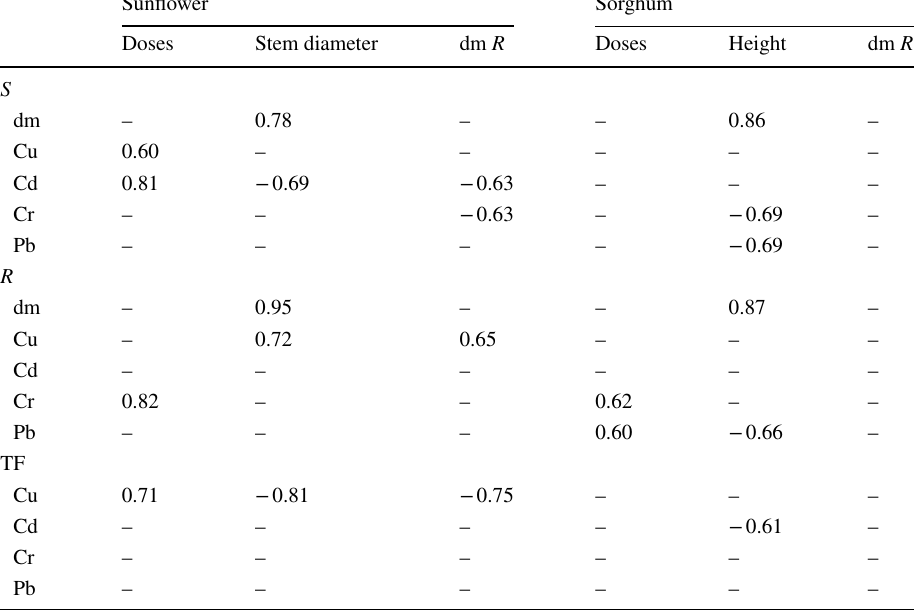
coefficients ( r ) for shoots ( S ), roots ( R ), and translocation factor (TF) of sunflower and sorghum on soils under industrial landfill sludge (ILS)